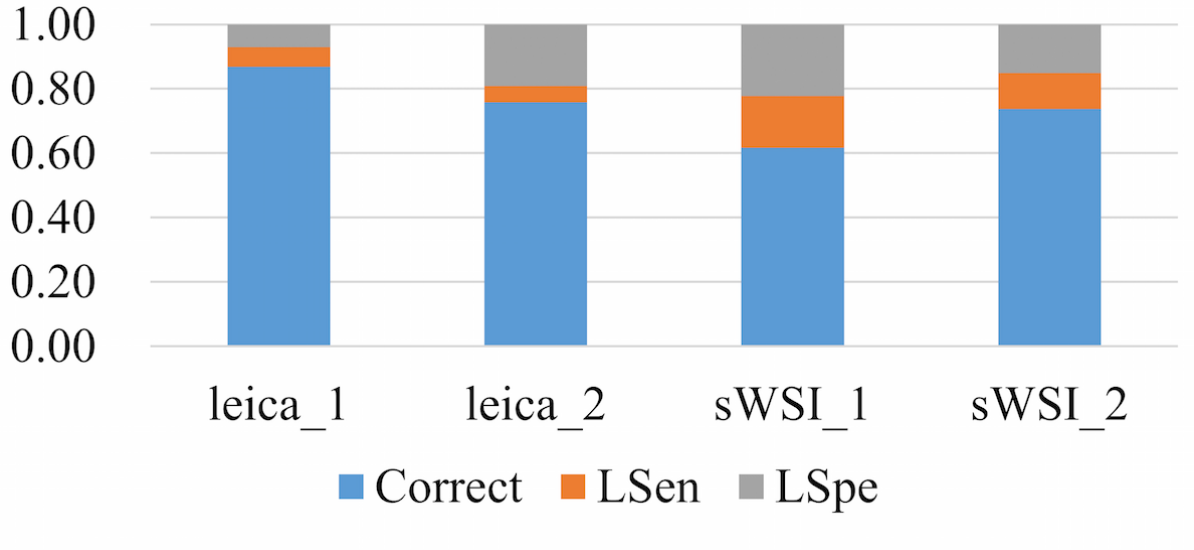
Figure 12. Performance based on scanner and sWSI virtual slides, averaged. LSen: low sensitivity; LSpe: low